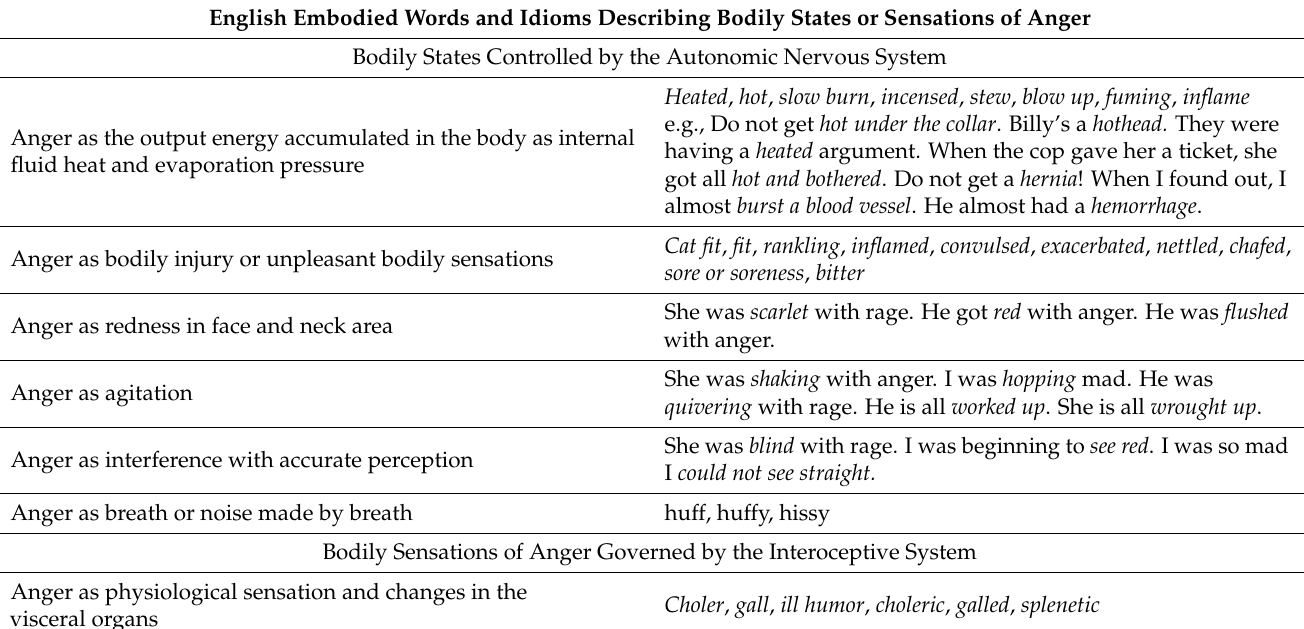
Table 4. English embodied words and idioms describing bodily states or sensations of anger. English Embodied Words and Idioms Describing Bodily States or Sensations of